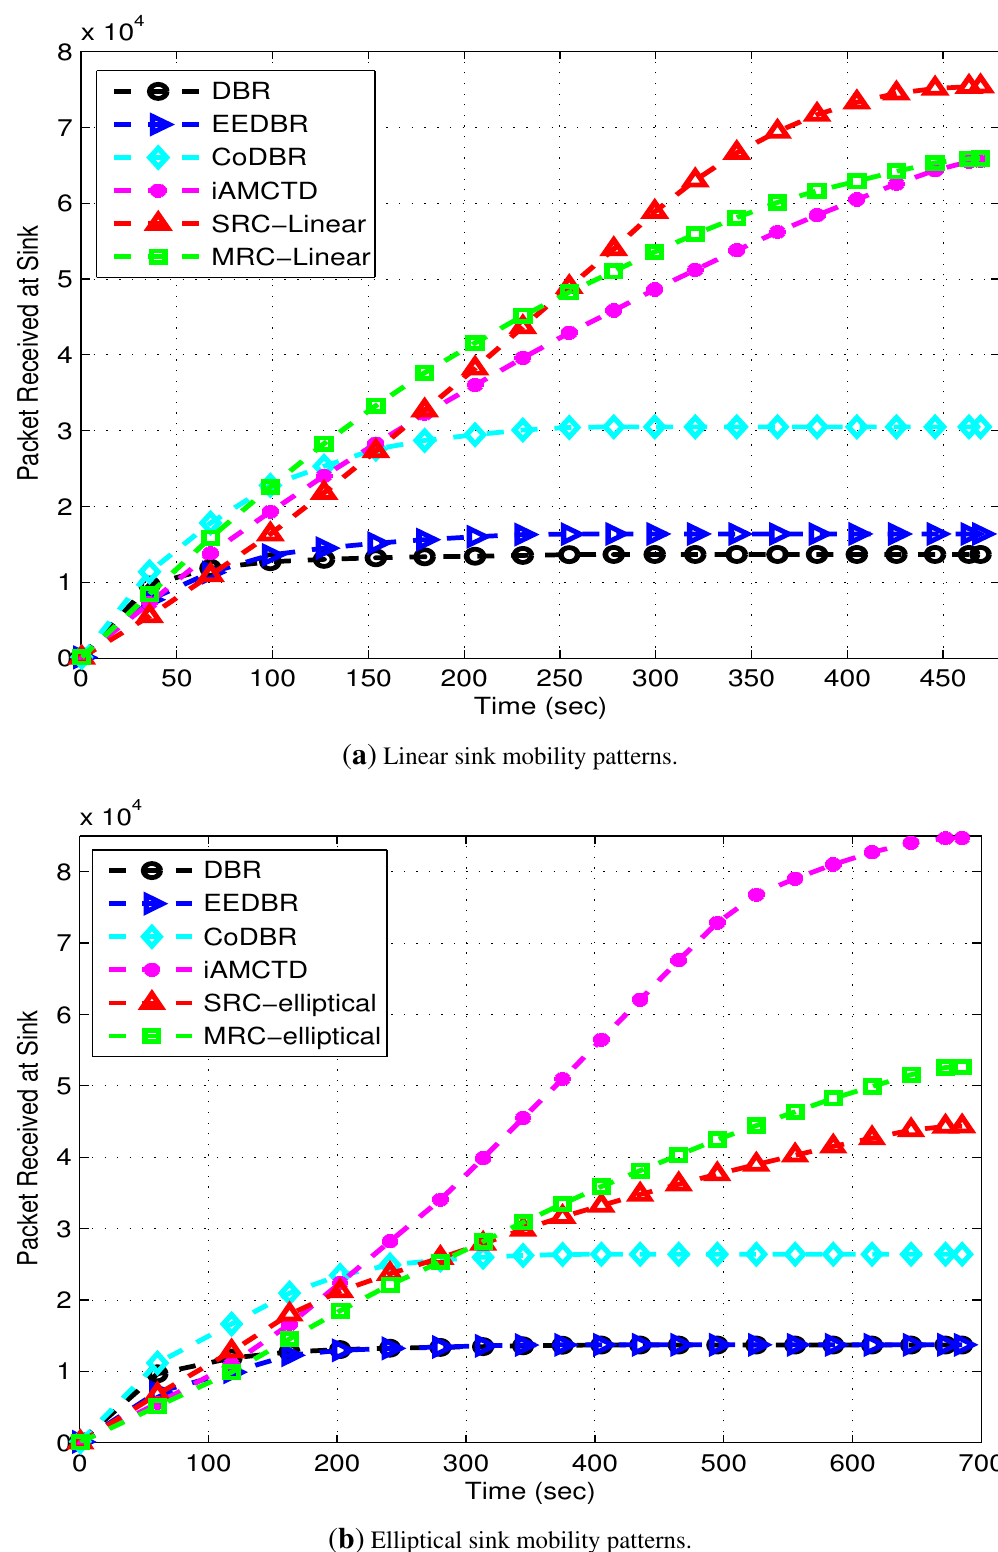
Figure 12. Packets received at MSs in the networks with linear and elliptical sink